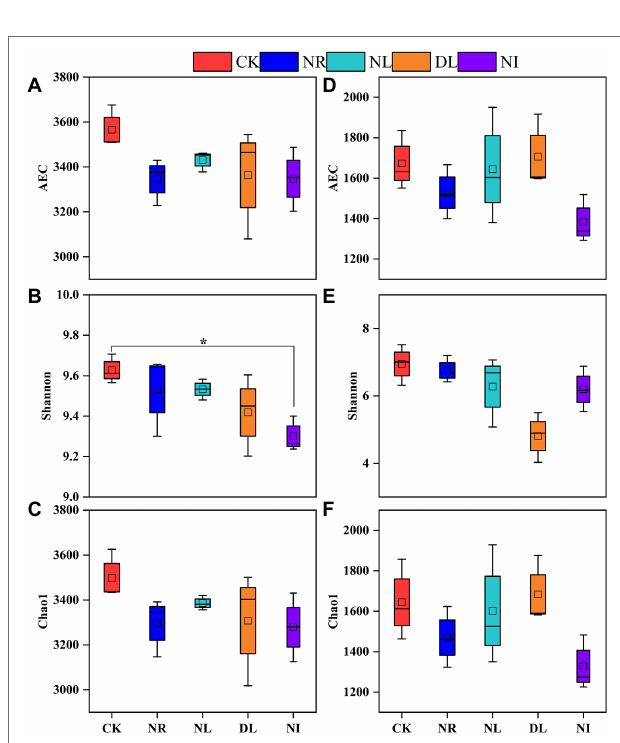
FIGURE 5 | Alpha diversity of soil bacteria (A–C) and fungi (D–F) under different treatments ( n = 3). CK, DL, NL, NR, and NI represent control, doubled litter input, litter removal, root exclusion, root and litter exclusion, respectively. Asterisk indicate significance: * p <